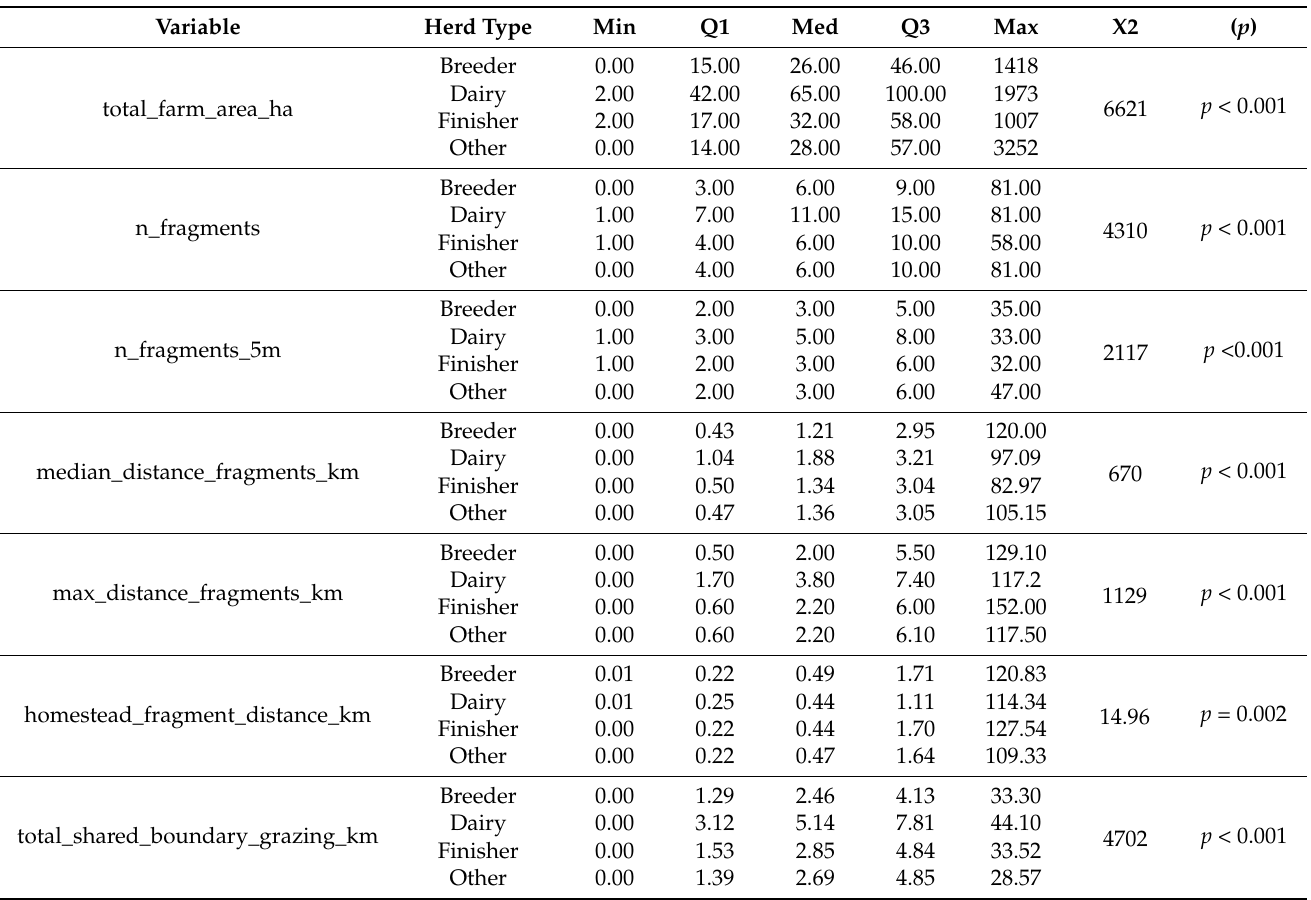
Table 2. Measures of farmland fragmentation, fragment dispersal, farm contact and land classification associated with different production types. The test statistics refer to Kruskal–Wallis Chi-squared